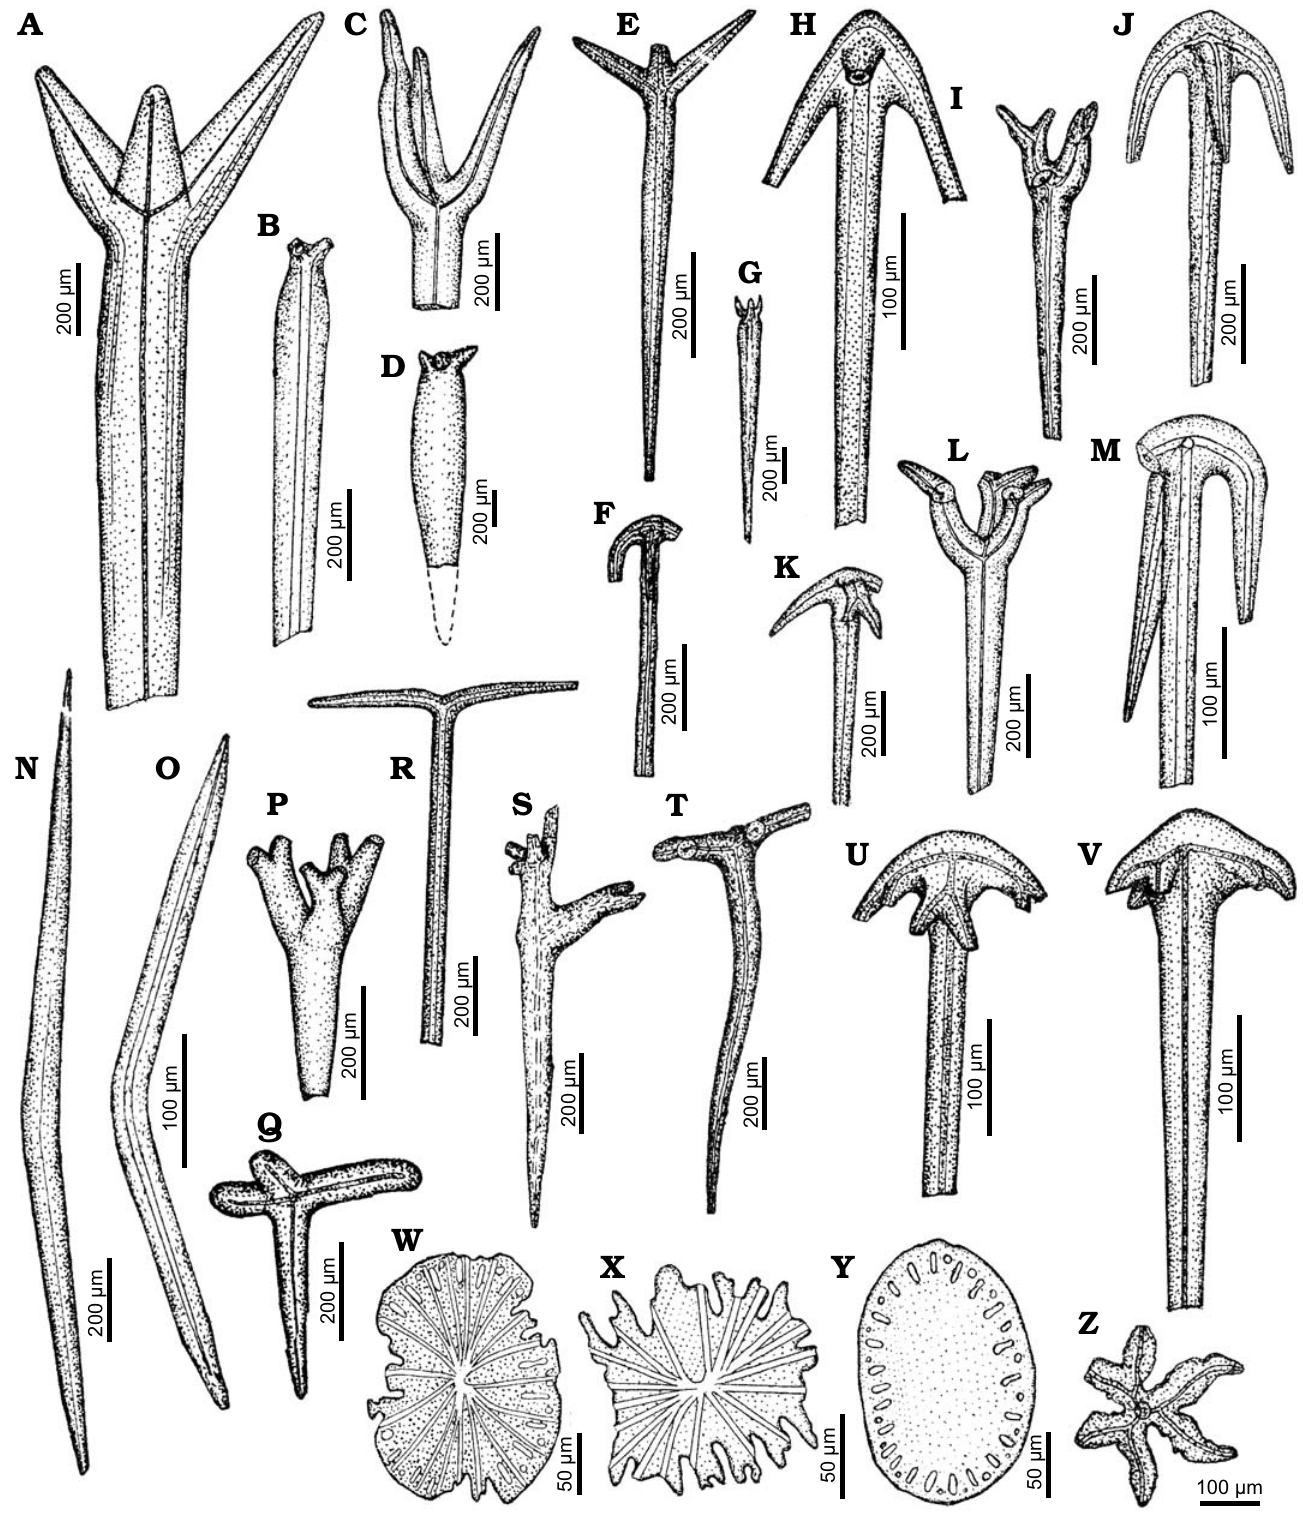
Fig. 2. Spicule morphotypes from south-central Ukraine; Č e č va, lower Oligocene (A, B), Staroverovka, middle Eocene (C, L), Verhnee, lower Eocene (D), Russkie Ti ŝ ki, middle Eocene (E, H, R, Z), Nikol’skoe, upper Eocene (F, I, J, K, M, T), Č ernoleska, upper Eocene (G), Markovka, upper Eocene (N), Melovoe, middle Eocene (O), Glâdov Âr, Cretaceous (P), Markovka, lower Oligocene (Q), Lipcy, middle Eocene (S), Pogonovka, upper Eocene (U), Melovoe, upper Eocene (V), Pes č anoe, upper Eocene (W, Y), and Kiselevka, upper Eocene (X). A – E , G . Protriaenes. F , H , J , K , M , U , V . Anatriaenes. I , L , P . Prodichotriaenes. N , O . Oxeas. Q . Orthotriaene. R . Diaene. S . ?Triaene. T . Orthodichotriaene. W – Y . Pinakids. Z . Dichotriaene. After Ivanik (2003);